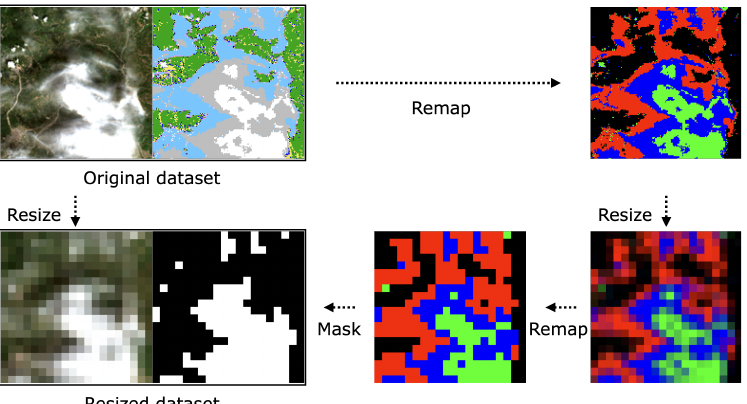
Figure 8. Label resize for scaling down the size of the label. Thin cirrus, high probability cloud, and medium probability cloud features are remapped to red, green, and blue channels. Channel-wise feature decomposition gives a higher degree of freedom in averaging methods upon